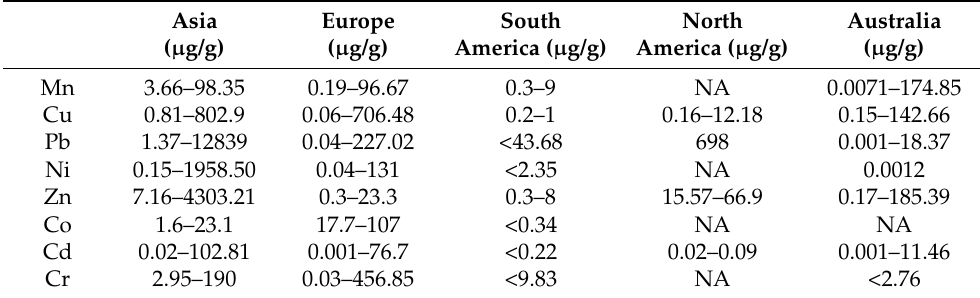
Table 3. The range of concentrations of heavy metals is frequently detected in MPs. Reprinted with permission from Ref. [149]. 2017, Kutralam-Muniasamy, G.; Perez-Guevara, F.; Martinez, I.E.; Shruti,